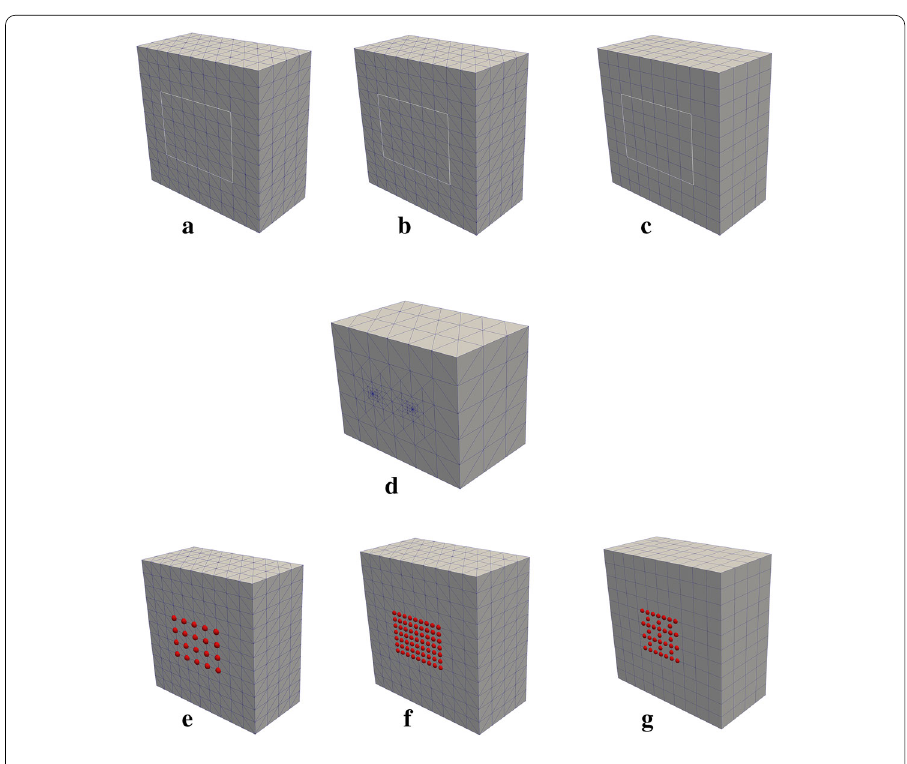
Fig. 15 Meshes used for the GFEM gl analysis of a 3-D surface crack— a TET4 initial global mesh— b TET10